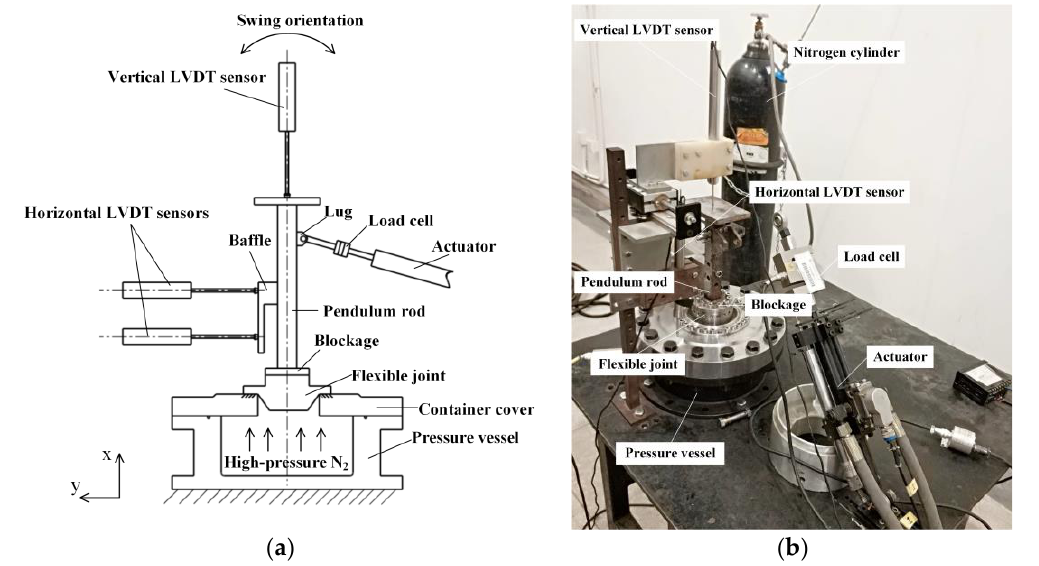
Figure 8. Swing test device for flexible joint: (a) Plane structure diagram (b) actual swing test device.